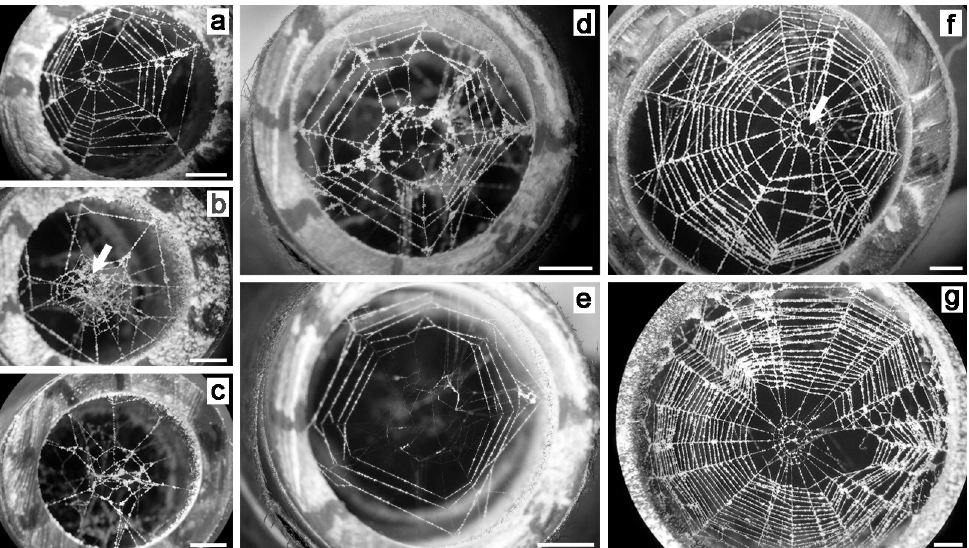
Fig 2. Orb webs built by Leucage argyra spiderlings in cylinders of different diameters in the laboratory. a-e) Orbs in 9 mm diameter cylinders: a) with many sticky spiral loops, b) with only one sticky spiral loop and an intact hub center (arrow indicates tufts of silk that accumulated during radius construction), c) with no sticky spiral, d) immediately after being coated with powder, e) after rapping the cylinder gently to displace the powder from the non-sticky lines; f) orb in a 18 mm diameter cylinder (white arrow indicates the hole where the center of the hub was removed); and g) orb in a 24 mm in diameter cylinder. All scale bars are 2 mm.